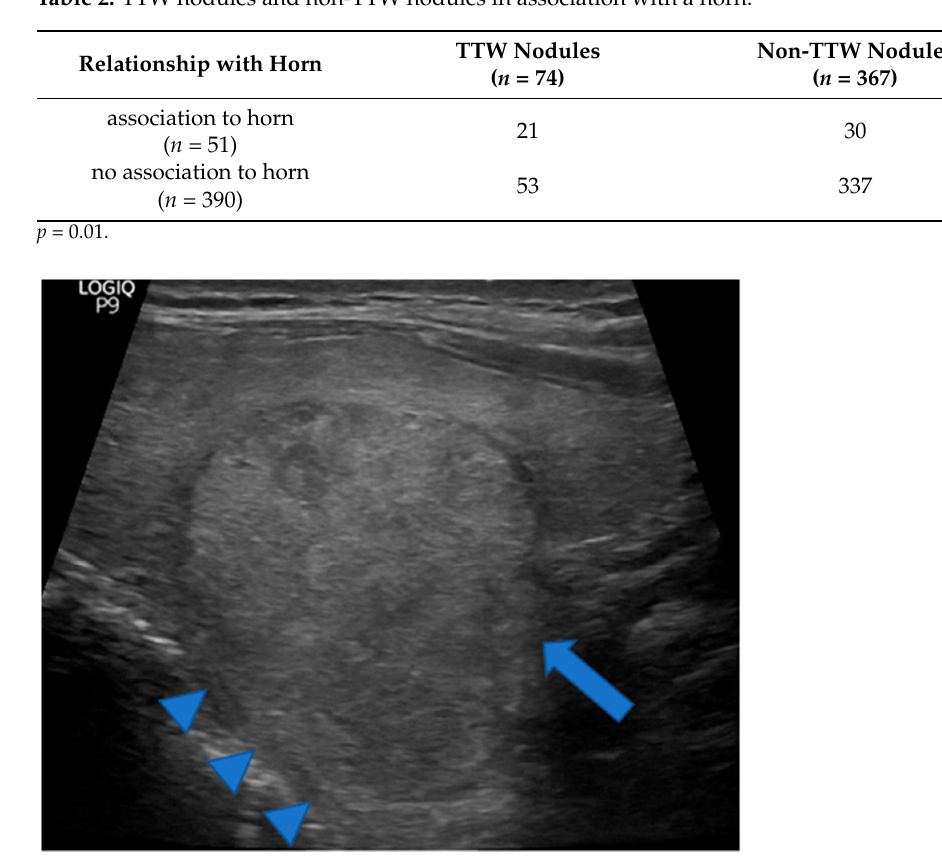
Figure 5. Huge TTW nodule extending into a prominent posterior horn (arrowheads). Note the thyroid parenchyma extending along the cranial portion of the nodule (arrowheads) but not along the caudal portion (arrow) arguing for a pre-existing posterior horn. A pre-existing posterior horn may have channeled the way for nodule growth causing its taller than wide shape. The nodule was benign at cytology. The following figure (Figure 6) gives the frequency and configuration of a typical benign nodule—excluding the six carcinomas—from the prospective part of the study with regard to its location within the thyroid gland.